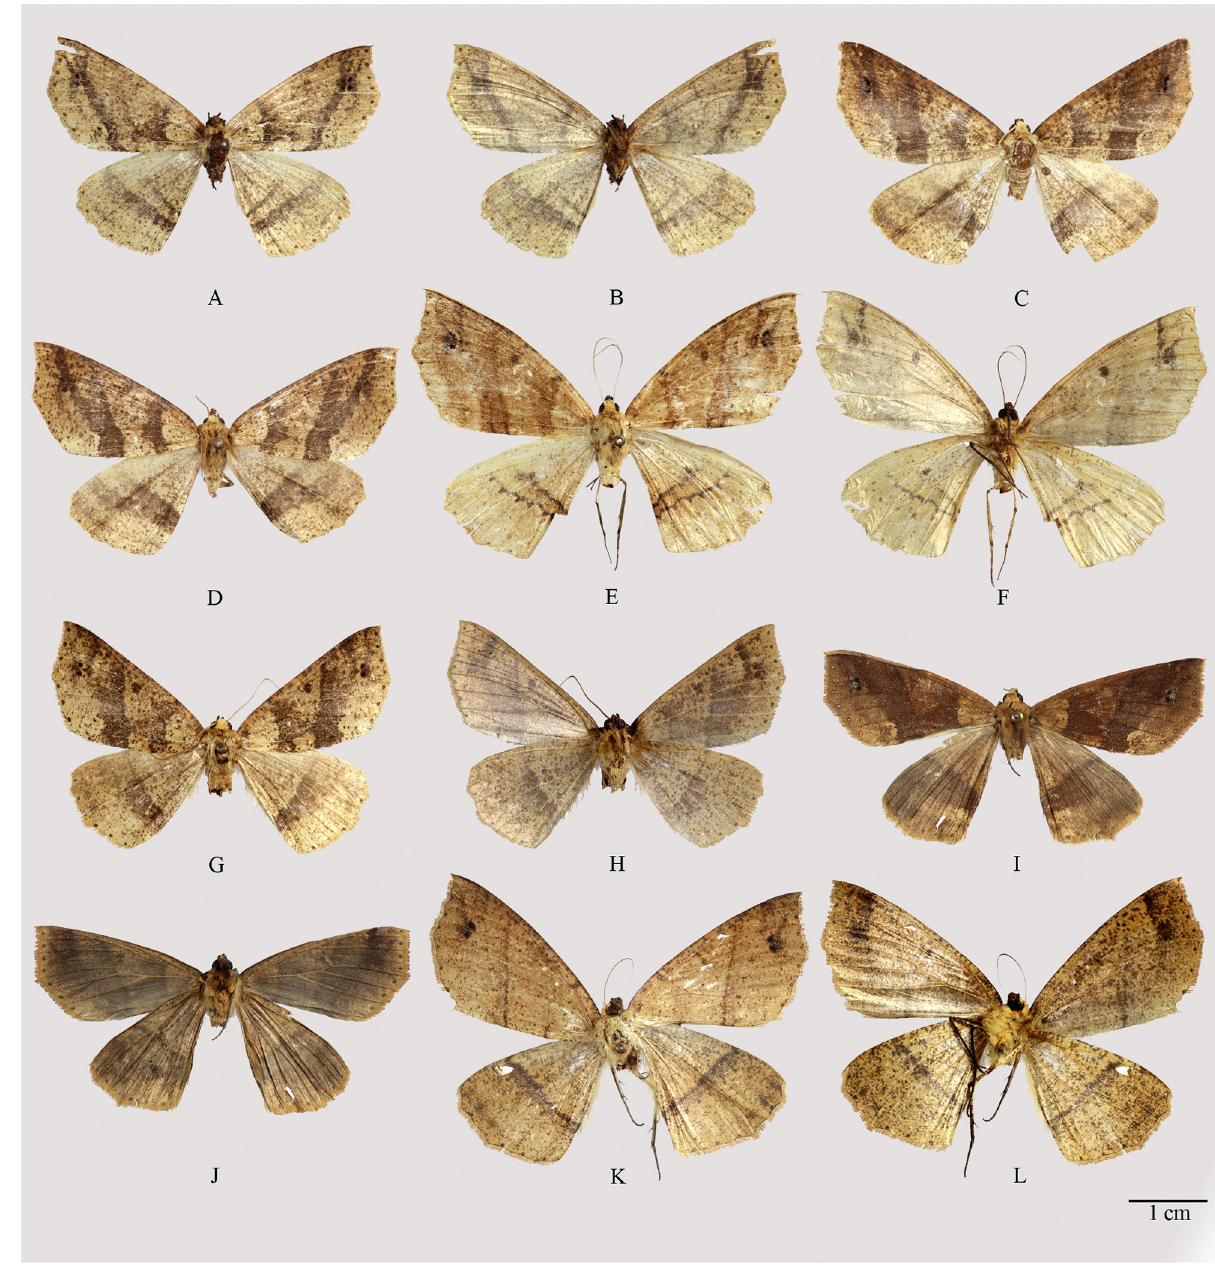
Fig 13. Habitus of Psyra crypta , P . spurcataria . A. P . crypta ♂ B. P . crypta ♂ underside C. P . crypta ♂ D. P . crypta ♂ E. P . crypta ♀ F. P . crypta ♀ underside G. P . spurcataria ♂ H. P . spurcataria ♂ underside I. P . spurcataria ♂ J. P . spurcataria ♂ underside K. P . spurcataria ♀ L. P . spurcataria ♀